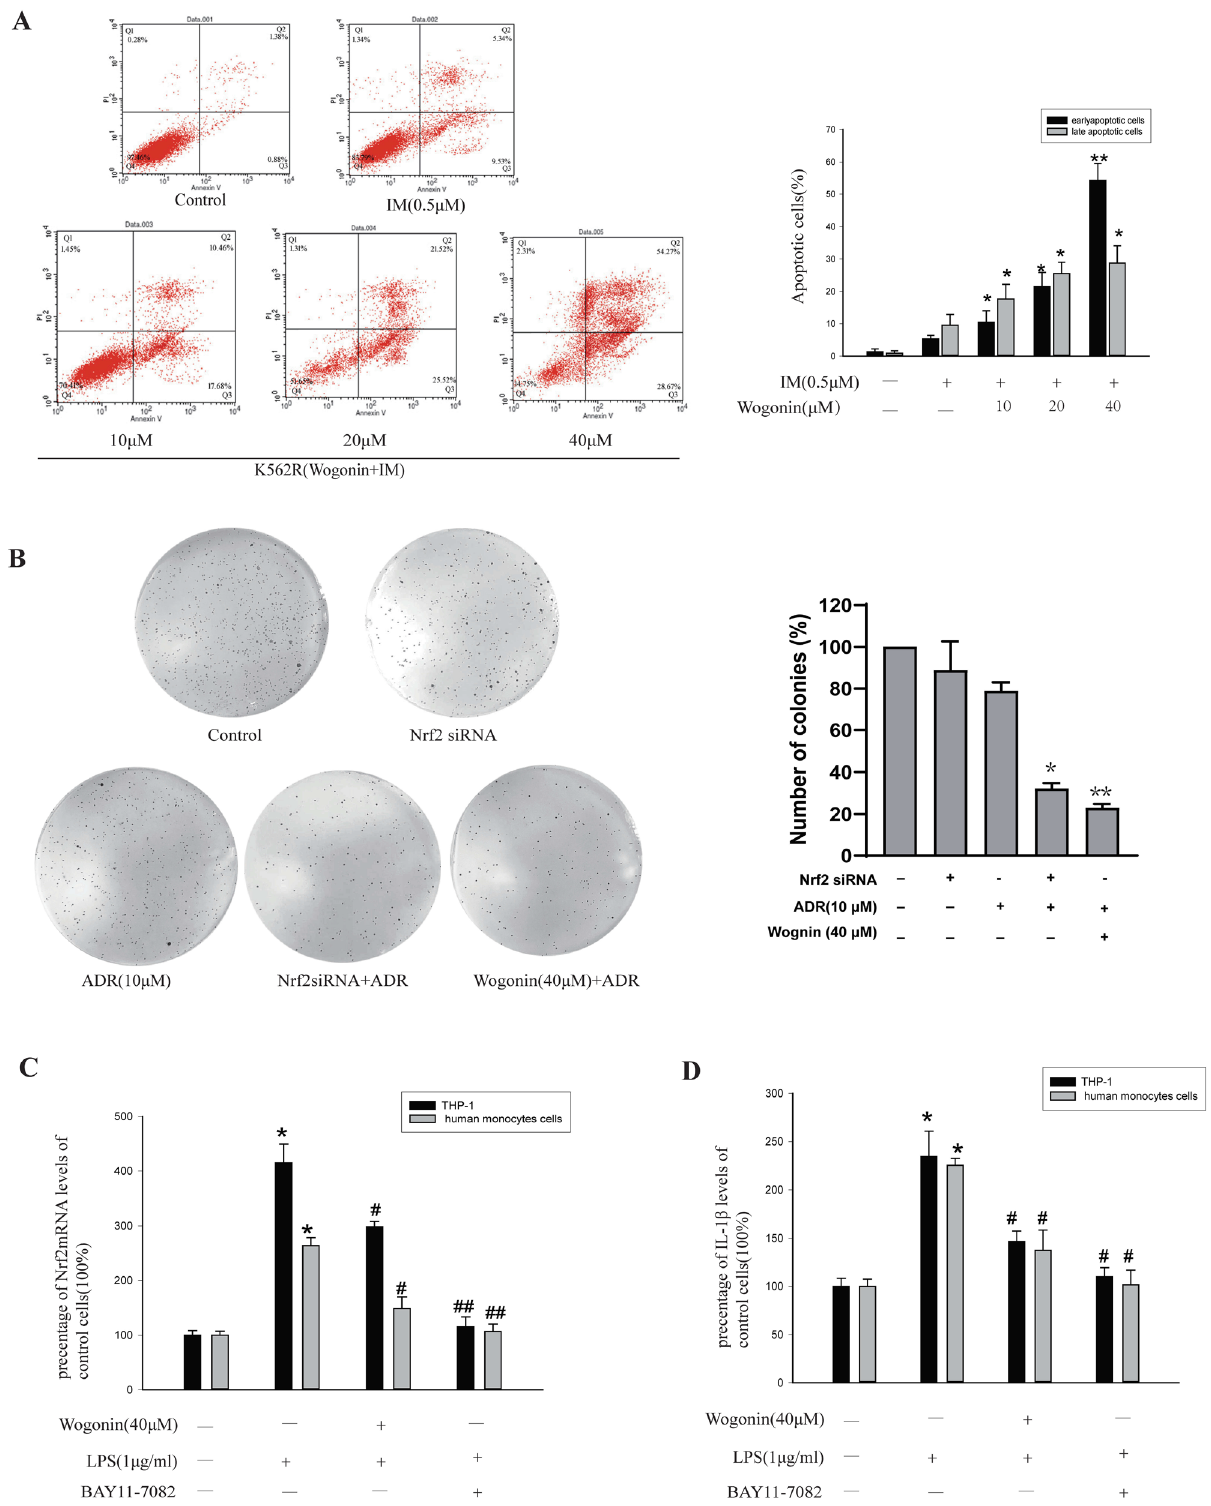
Figure 2. A correct version of original figure